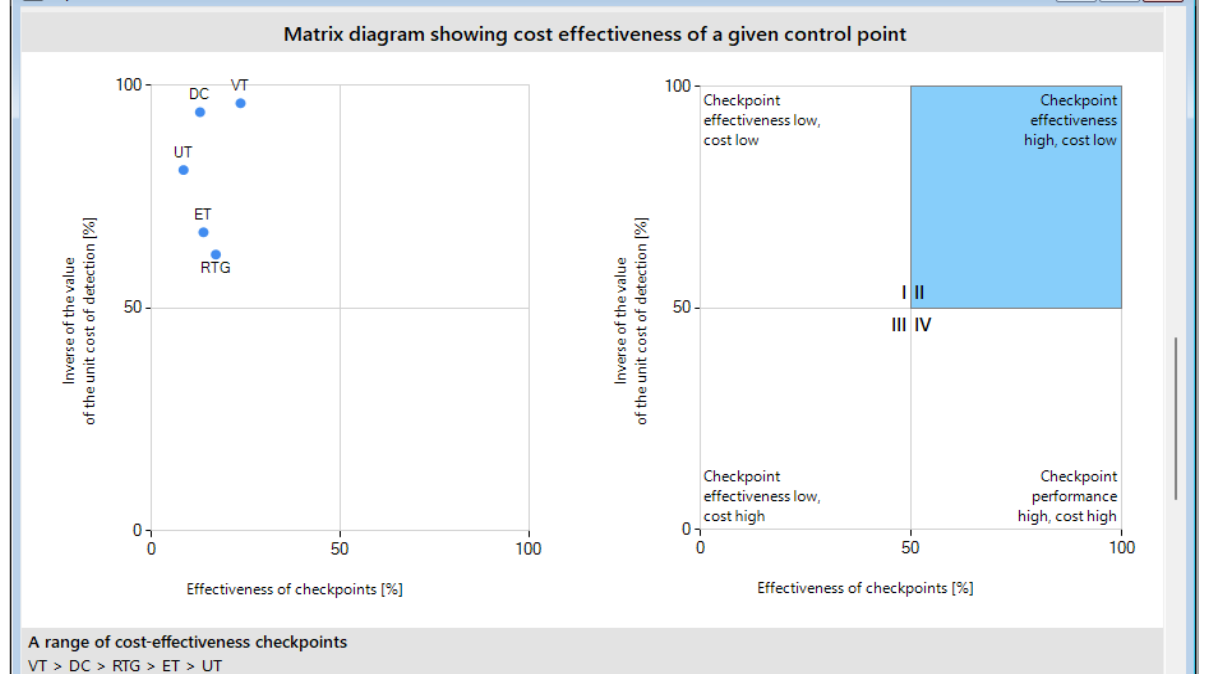
Figure 8. Part three of the report on the effectiveness of control methods—analysis of the level of cost-effectiveness of detection methods.